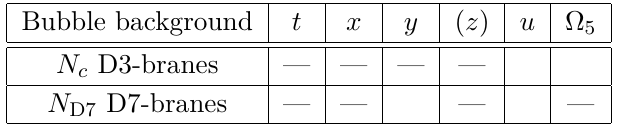
Table 2 . The configuration of the D-branes in the bubble solution